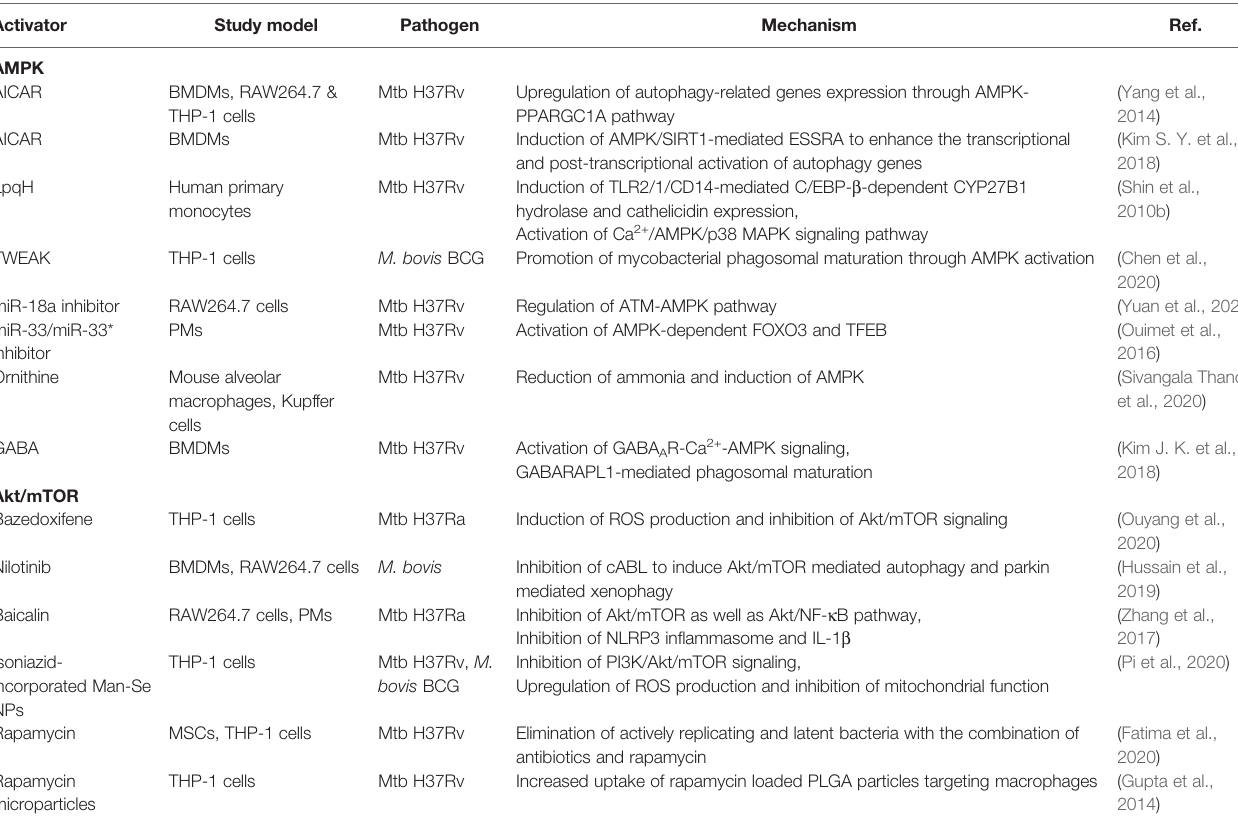
TABLE 1 | Autophagy-based antimicrobial responses acting through AMPK and Akt/mTOR pathways.